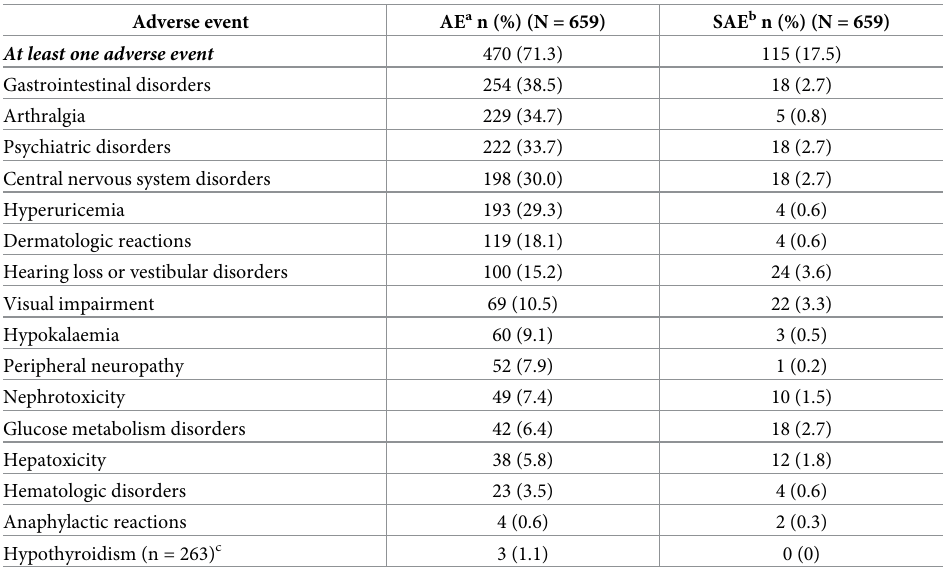
Table 2. Adverse events occurring during MDR-TB